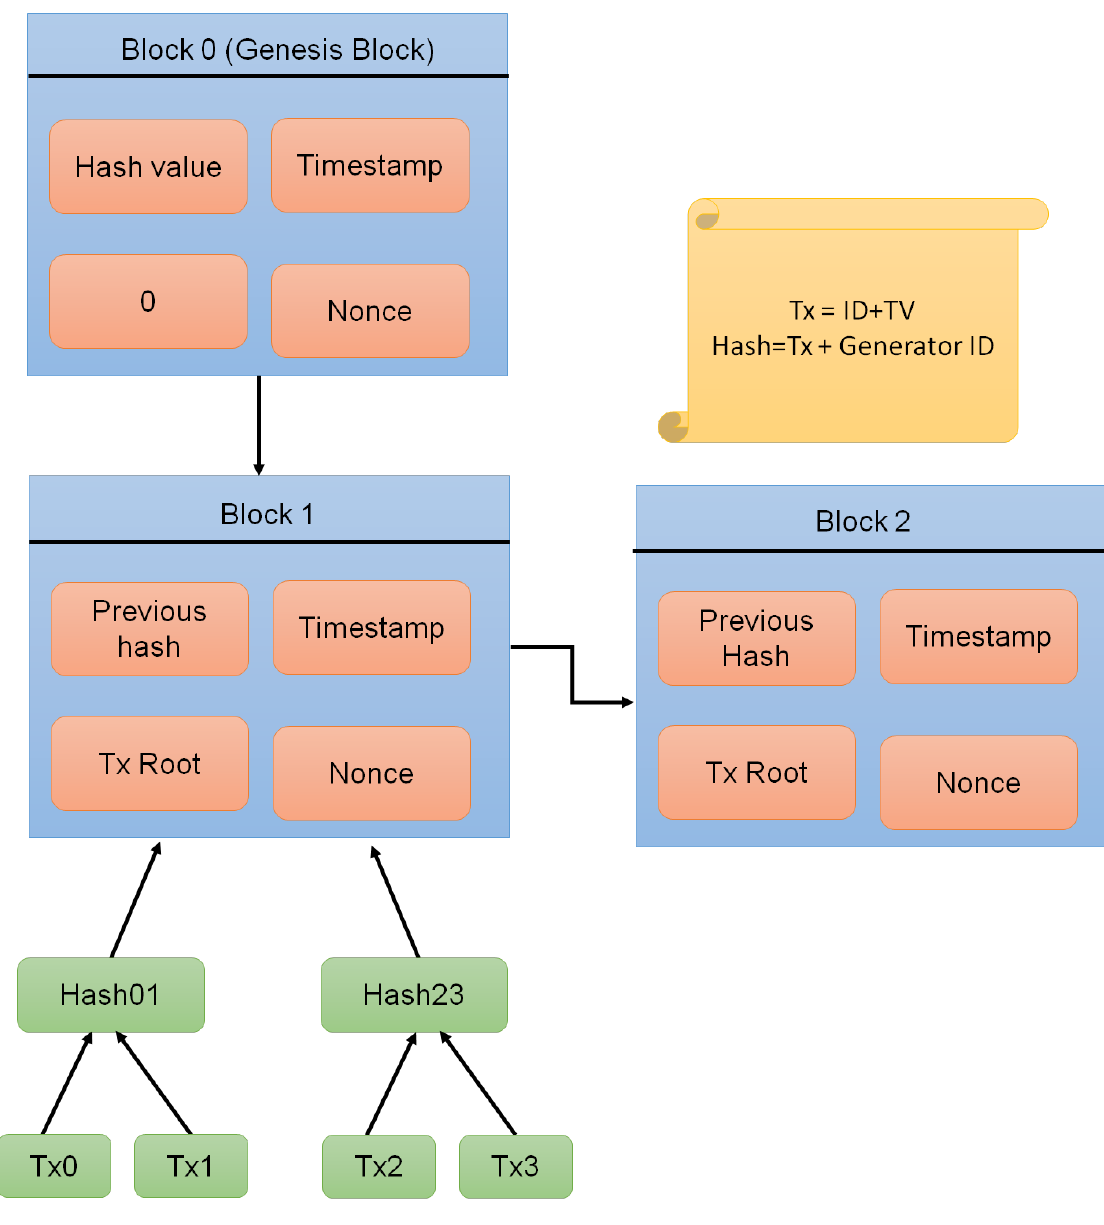
Figure 4. Sample Block Configurations.